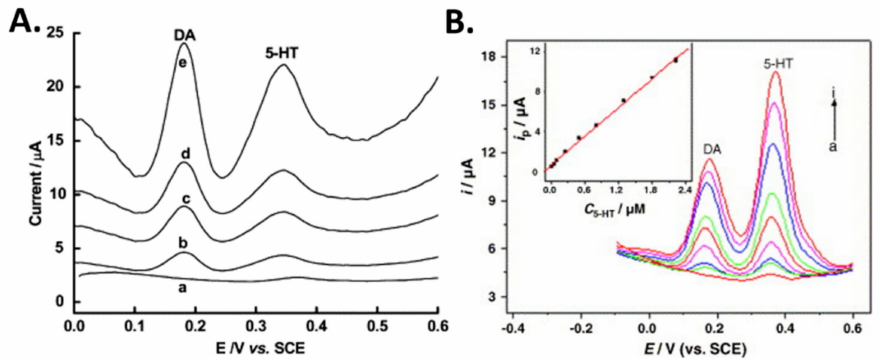
Figure 8. Di ff erential pulse voltammetry (DPV) of dopamine (DA) and serotonin (5-HT) in the human serum conducted using ( A ) MWCNT—DHP film-coated GCE for (a) 0, (b) 0.05, (c) 0.1, (d) 0.2, (e) 0.4 µ M DA and 5-HT. ( B ) DPVs of DA + 5-HT at nano-Au / PPyox / GCE with variously spiked concentrations: (a–i) 0, 0.05, 0.1, 0.25, 0.5, 0.8, 1.3, 1.8, 2.2 µ M. Reprinted with permission